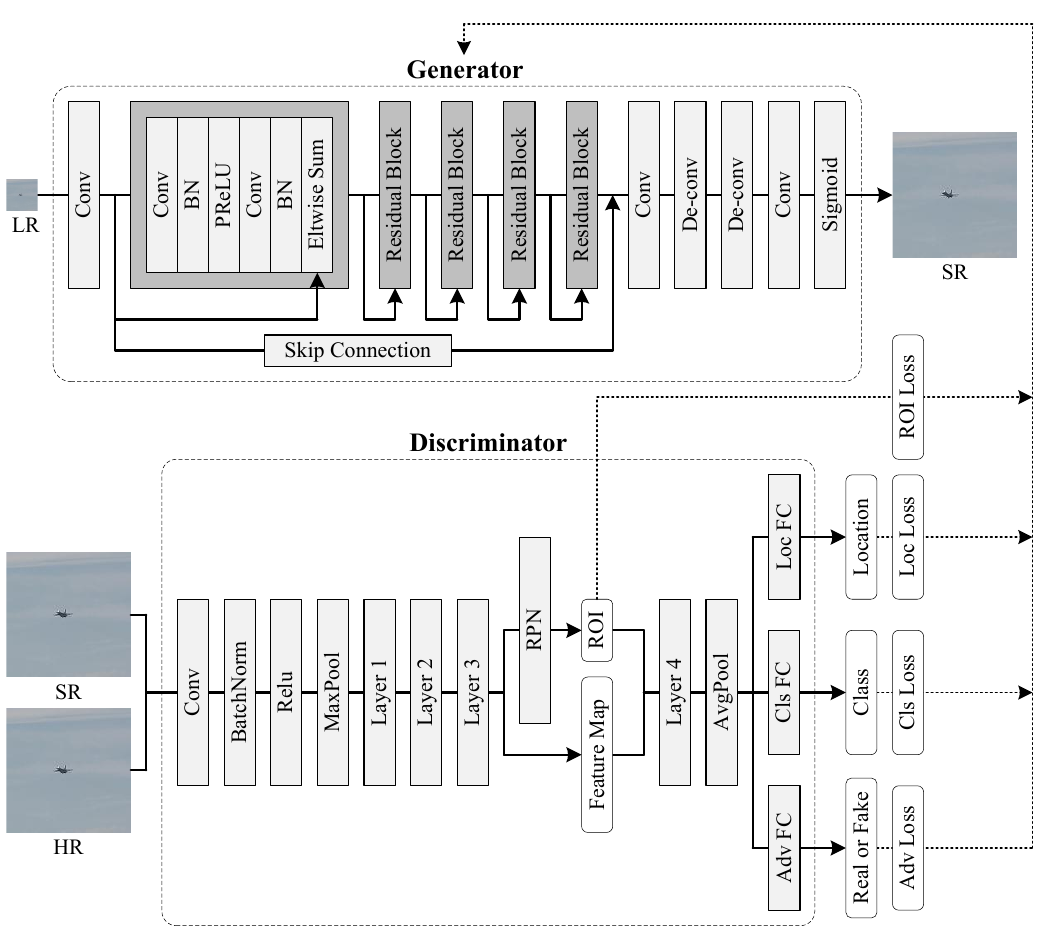
Figure 2. Architecture of